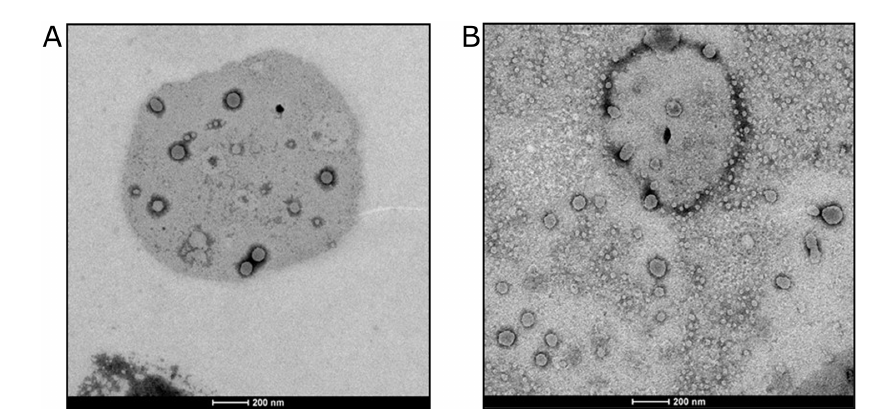
Figure 2. TEM images of (A) the SEC-isolated and (B) kit-isolated exosome-like nanoparticles of roasted ground coffee. TEM, transmission electron microscopy; SEC, size exclusion chromatography.